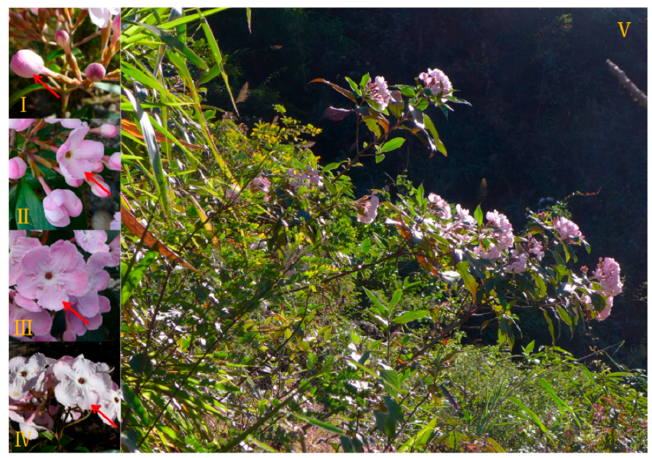
Figure 1. Different development stages of L. yunnanensis and its habitat. (I) bud stage; (II) initial-flowering stage; (III) full-flowering stage; (IV) end-flower stage; (V) habitat of L. yunnanensis .